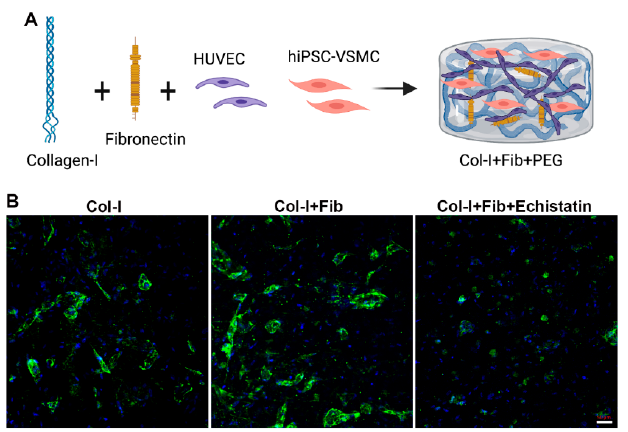
Figure 3. Characterization of hiPSC-VSMC and HUVEC hydrogels. ( A ) The schematic shows hiPSC-VSMC and HUVEC in fibronectin functionalized collagen hydrogel-forming EC networks. ( B ) Fluorescent images of hiPSC-VSMC and HUVEC hydrogels stained with CD144 on Day 7. The different hydrogels were collagen only (Col-I), fibronectin functionalized collagen hydrogel (Col-I + Fib), and Col-I + Fib hydrogel treated with Echistatin (Col-I + Fib + Echistatin). Dapi (Blue) was used to stain nuclei. The scale bar measures 50 µm.